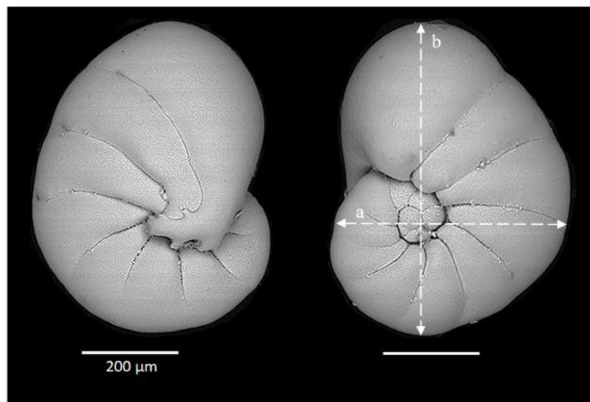
Figure 4. Scanning electronic microscope images of a Nonionella sp. T1 from the GF17-3 oxic station in the Gullmar Fjord. White lines (labeled a and b) correspond to measured distances serving for a spheroid prolate volume